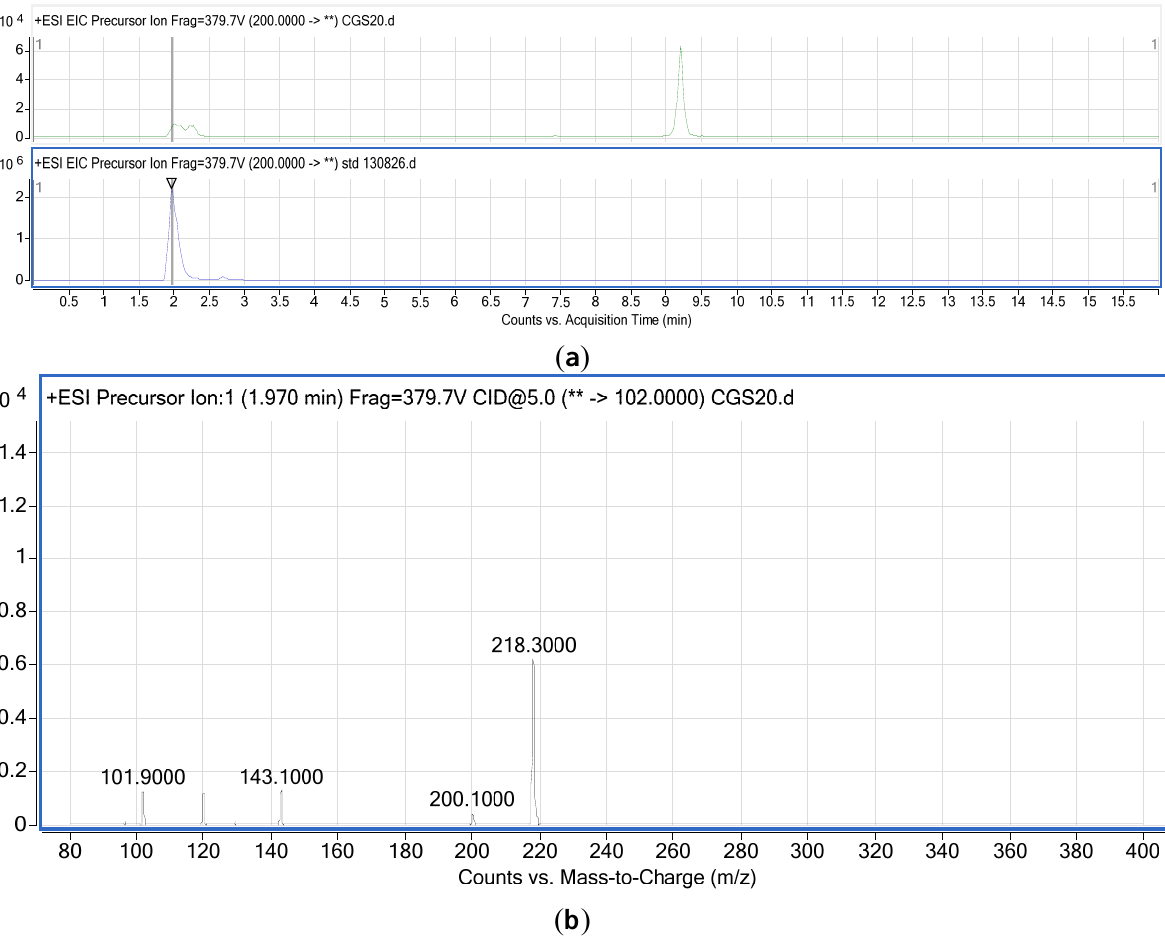
Figure 3. Mass spectra of AHLs extracted from K. pneumoniae strain CSG20 supernatant. ( a ) Total ion chromatogram of AHLs extract strain CSG20 and standard C6-HSL. ( b ) MS analysis of AHLs extract strain CGS20 shown product ion m/z 101.90 and precursor